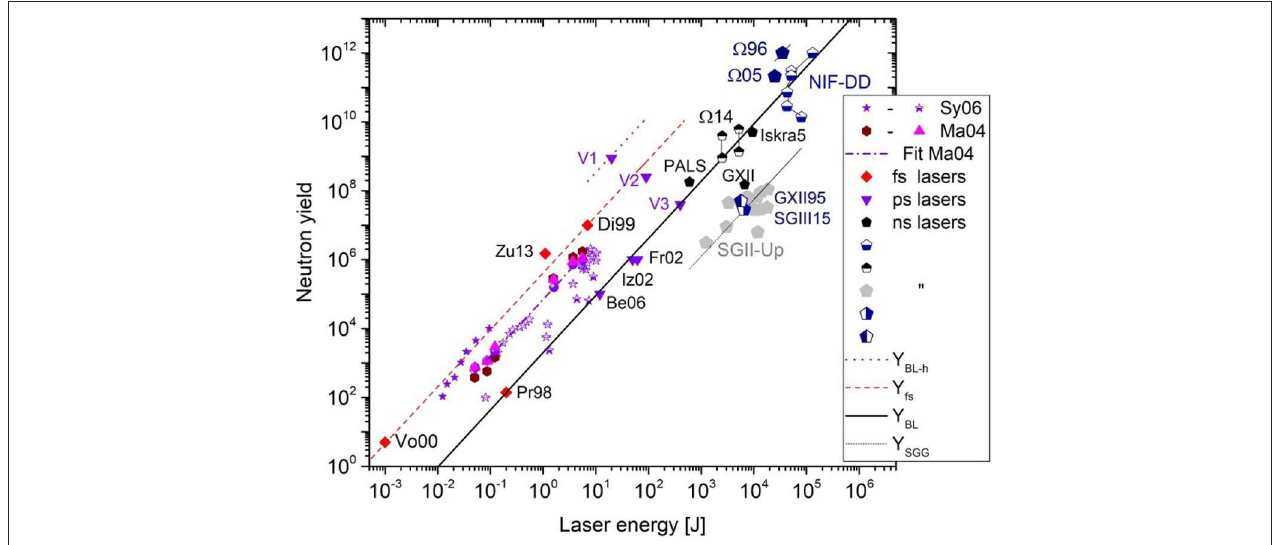
FIGURE 2 | Selected DD-fusion experiments associated with laser energy dependence of fusion neutron yields obeying the power law Q · E 1.65 , where Q SGG = 14 (short dash line), and Q BL = 2,000 (solid line), Q fs = 7.1 × 10 4 (dash-dot line) for explosions of deuterium clusters [2], Q fs = 4.1 × 10 5 (dash line) and Q fs = 7.5 × 10 6 (dot line). Data from References: Ma04 [2], Sy06 [10], Vo00 [13], Pr98 [17], Be06 [18], Iz02 [19], Fr02 [28], Zu13 [33], Di99 [34], V1 [25], V2 [26], V3 [27], PALS [20], Ω 14 [ 22], Iskra5 [21], NIF-DD [23], Ω 05 [31], Ω 96 [14], SGII-Up [12], GXII [29], GXII95 [32], and SGIII15 [30].